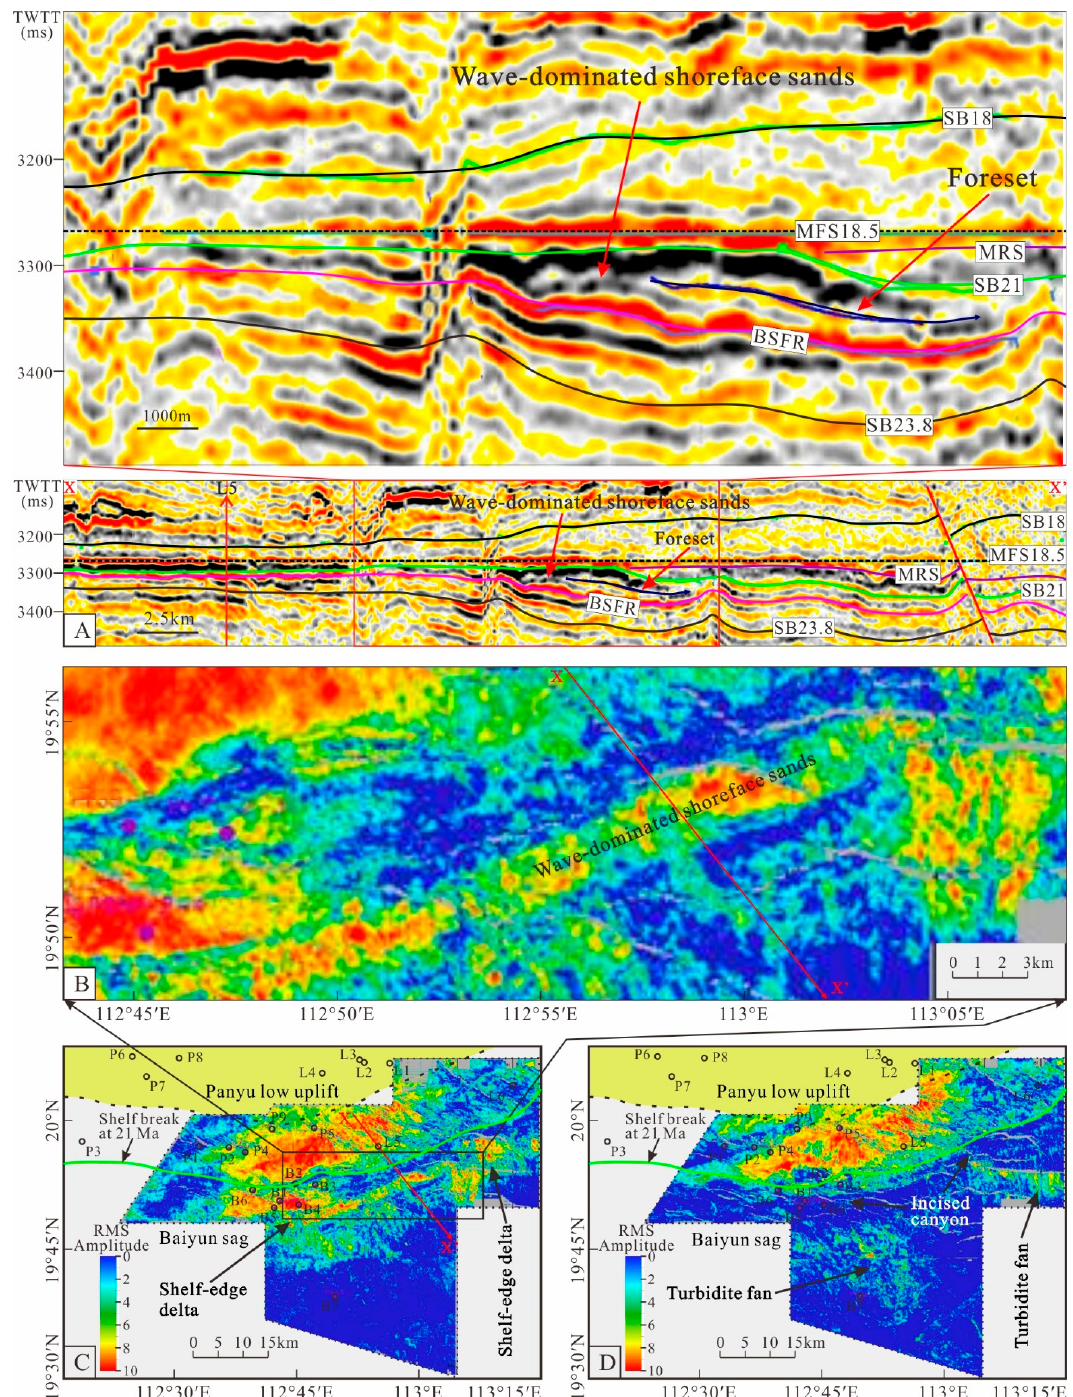
Figure 9. ( A ) Seismic reflection features of falling stage systems tract in the depositional trends (location of section is given in Figures 1B and 9C). ( B ) Local amplification of root mean square amplitude attribute (location of section is given in Figure 9B). ( C ) Root mean square amplitude attribute extracted 30 ms downward from the 21 Ma which is the upper interface of falling stage systems tract. ( D ) Root mean square amplitude attribute extracted 30 ms upward from the basal surface of forced regression.